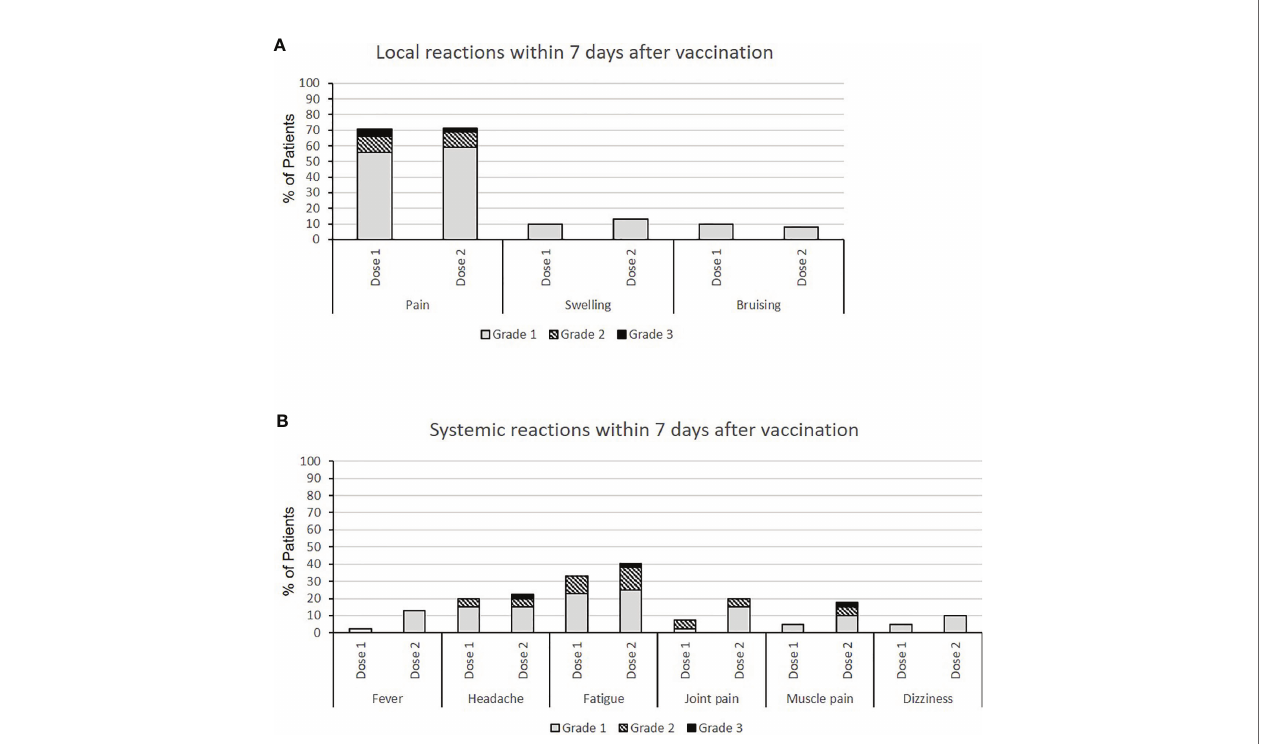
FIGURE 2 | (A) Local and (B) systemic adverse events (AEs) after the fi rst and the second dose of mRNA-1273 vaccine in 39 PD patients. The AEs were recorded using a standardized survey and the patients were asked to grade them using a scale from 0 to 4 (0=no event; grade 1=mild, does not affect daily activities; grade 2=moderate, interferes with activities of daily living; grade 3=severe, interrupts usual activities of daily living; grade